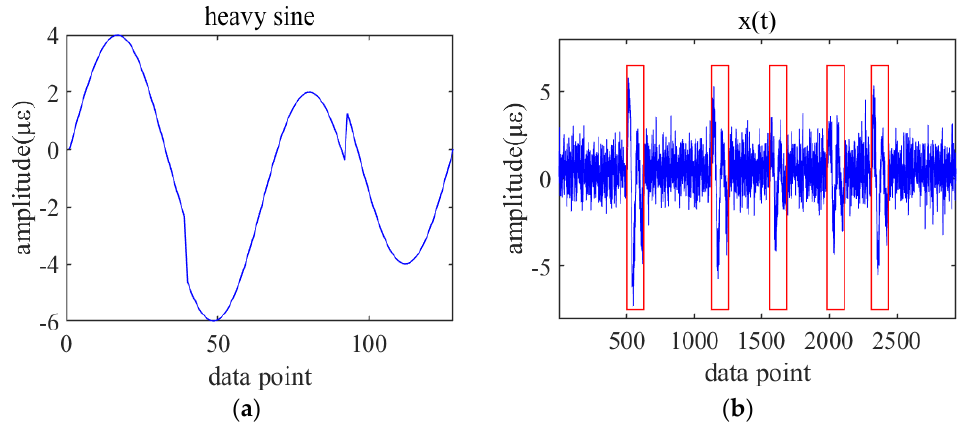
Figure 6. ( a ) Heavy sine signal. ( b ) Test signal x(t).